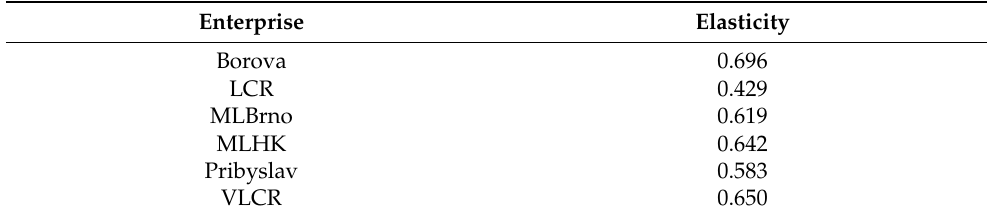
Table 9. Size elasticities (slopes) of leverage for the Czech forest enterprises.